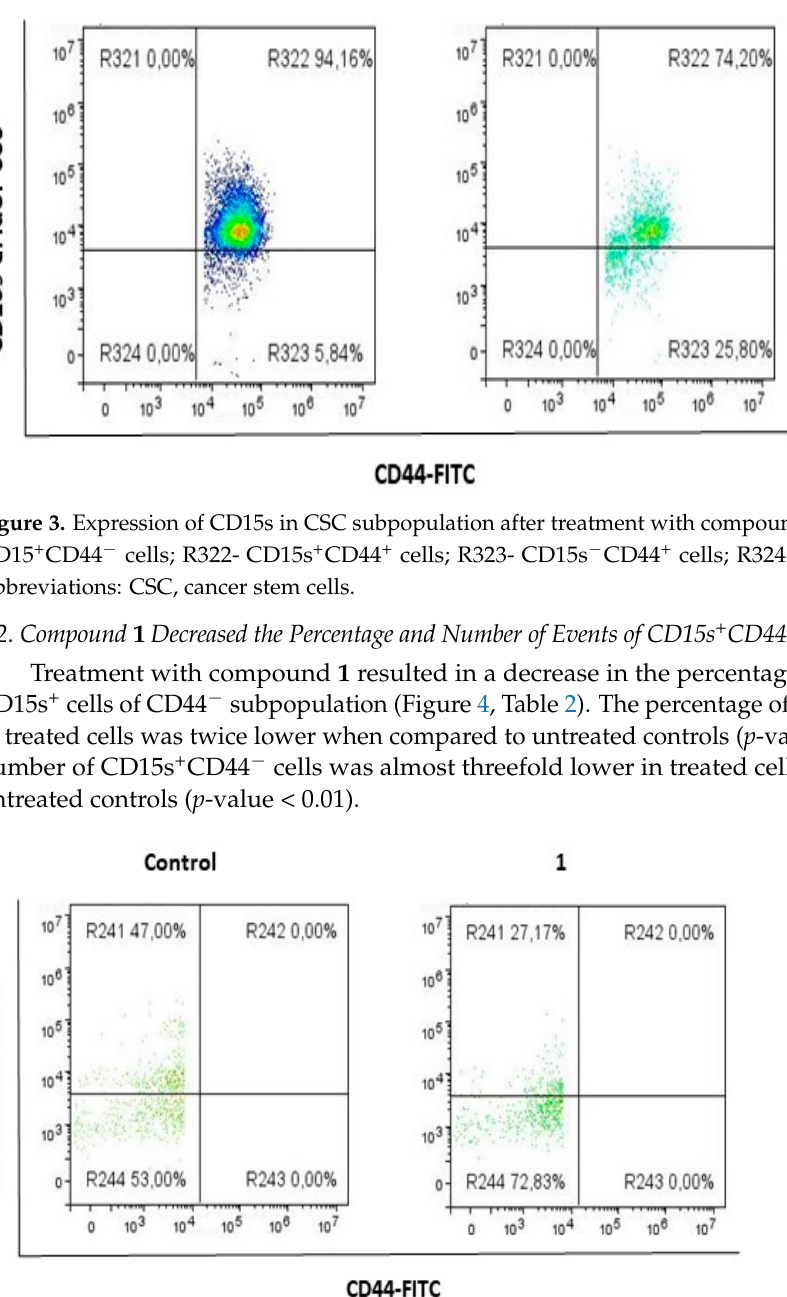
Figure 4. Expression of CD15s in CD44 - subpopulation after treatment with compound 1. Notes: